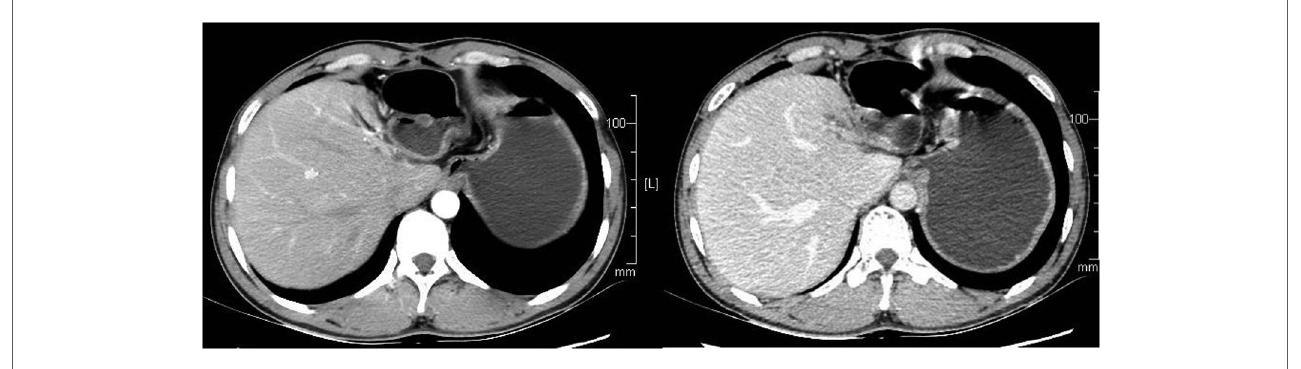
FIGURE 4 The patient had a CT scan 1 year after the operation, and no recurrence was found. CT, computed